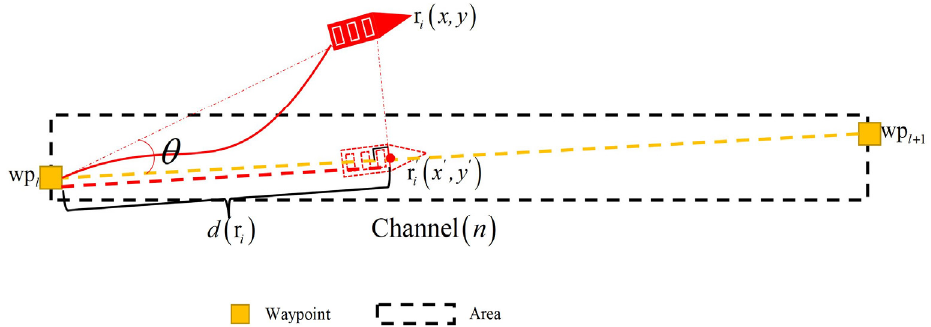
Figure 11. Projection position of MASS (unmanned ship) in the channel.